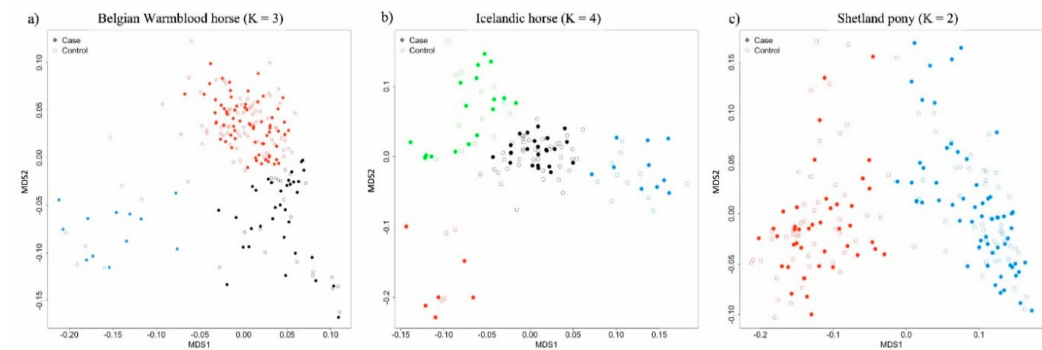
Figure 1. Multidimensional scaling (MDS) plot with the number of clusters assigned in ( a ) Belgian Warmblood horses (K = 3), ( b ) Icelandic horses (K = 4), and ( c ) the Shetland ponies (K = 2). Additionally, to investigate whether the higher density SNP-array in Belgian Warmblood horses rendered more significant results, a subset of SNPs was obtained representing the overlap between the 65 k Illumina equine HD chip and the 670 k A ff ymetrix Axiom Equine Genotyping Array. As a case study, a GWA analysis was performed in the Belgian Warmblood horse population using all SNPs (474,128 after quality control) and using the subset of SNPs for L_Culn7 (as most significant results were obtained using the IgE levels against this C. nubeculosus